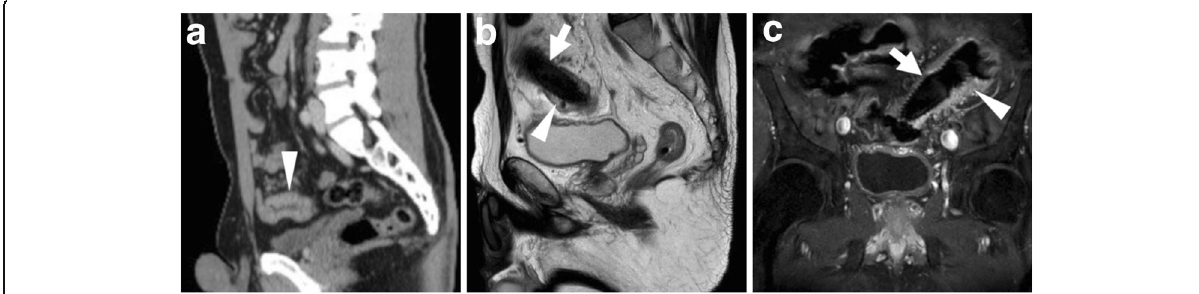
Fig. 4 Usual MRI appearance of a SEMS-treated CRC. At diagnosis, sagittal CT image ( a ) shows an endoscopically impassable, ulcerated CRC of the sigmoid colon as segmental mural thickening (arrowhead). After stent placement, sagittal T2- ( b ) and coronal fat-saturated T1-weighted after intravenous gadolinium contrast ( c ) MRI images show well-expanded SEMS (thick arrows) with patent lumen devoid of signal, and mural thickening (arrowheads) with T2-hypersignal ( b ) and positive enhancement ( b ) corresponding to the treated